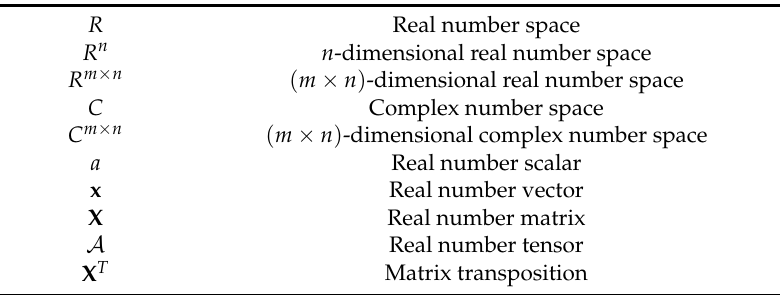
Table 1. Representations of basic